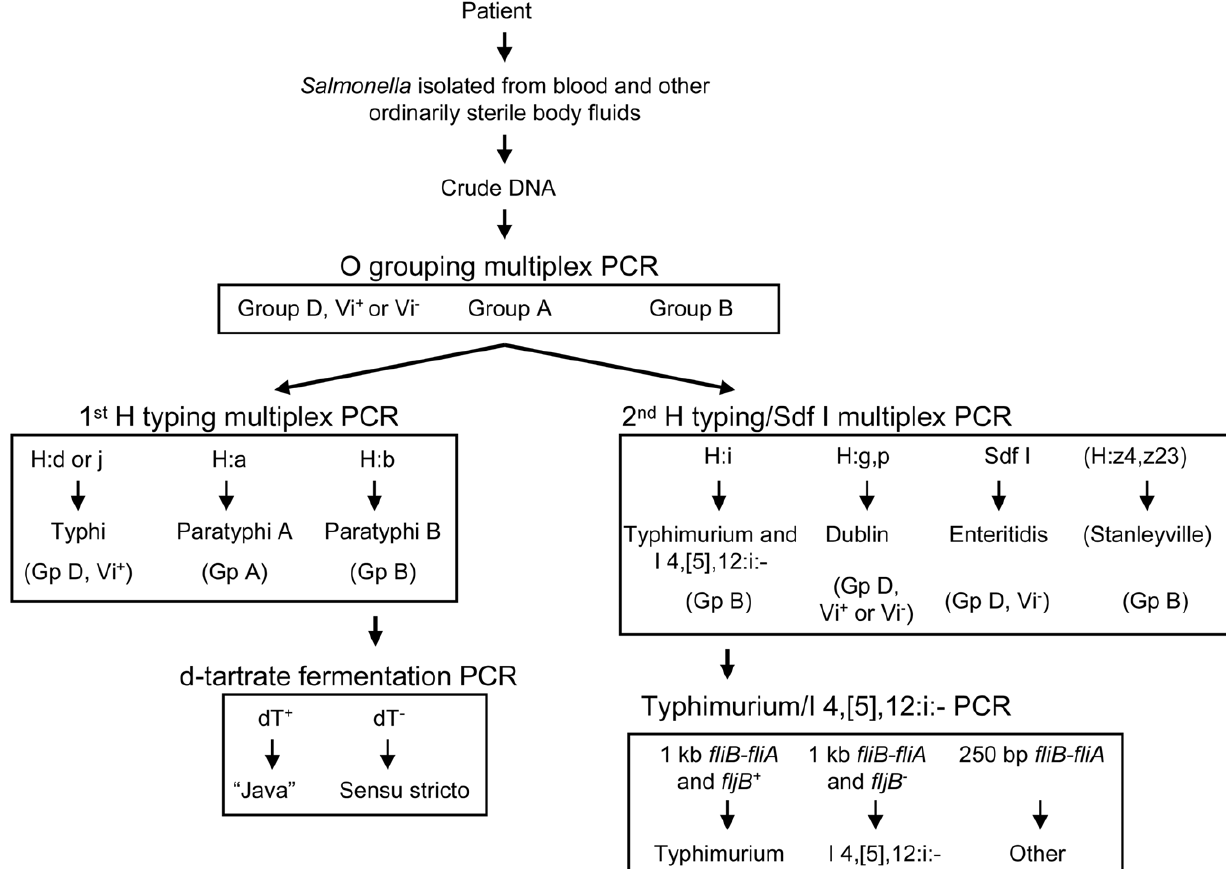
Figure 5. The steps used to identify typhoidal and non-typhoidal serovars of Salmonella isolated from blood.